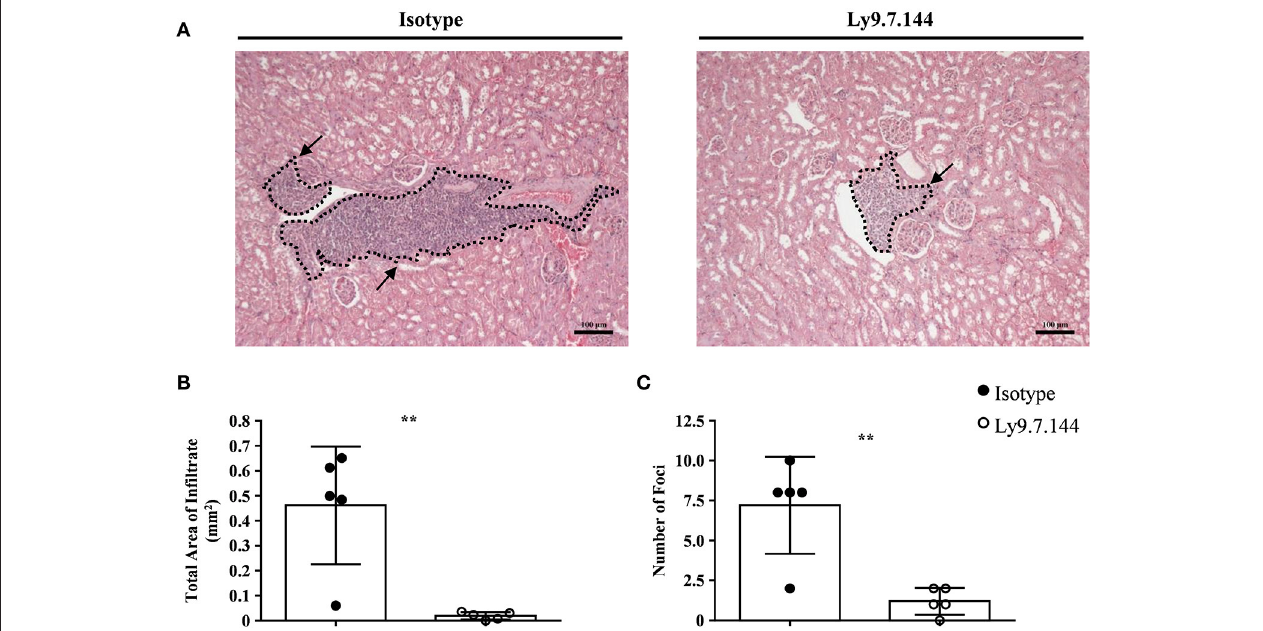
FIGURE 7 | Mice receiving anti-Ly9 treatment show a reduction in renal tubular epithelium infiltrates in SjS mice. Representative foci from anti-Ly9 (right) or isotype control (left) treated mice found in kidney H&E staining are shown (A). Total area of infiltrating cells (B) and foci number (C) were calculated from H&E staining of kidney paraffin-embedded tissue sections of NOD.H-2 h4 mice. Mice treated with Ly9.7.144 mAb are represented as empty dots and mice treated with isotype control are represented as black dots. Dotted lines contouring infiltrating areas are indicated with black arrows. The foci was defined as the presence of > 50 infiltrating leukocytes in continuum space. Results are expressed as mean ± SD. ** p < 0.01 (unpaired two-tailed t -test). Data is from one independent experiment (B,C)